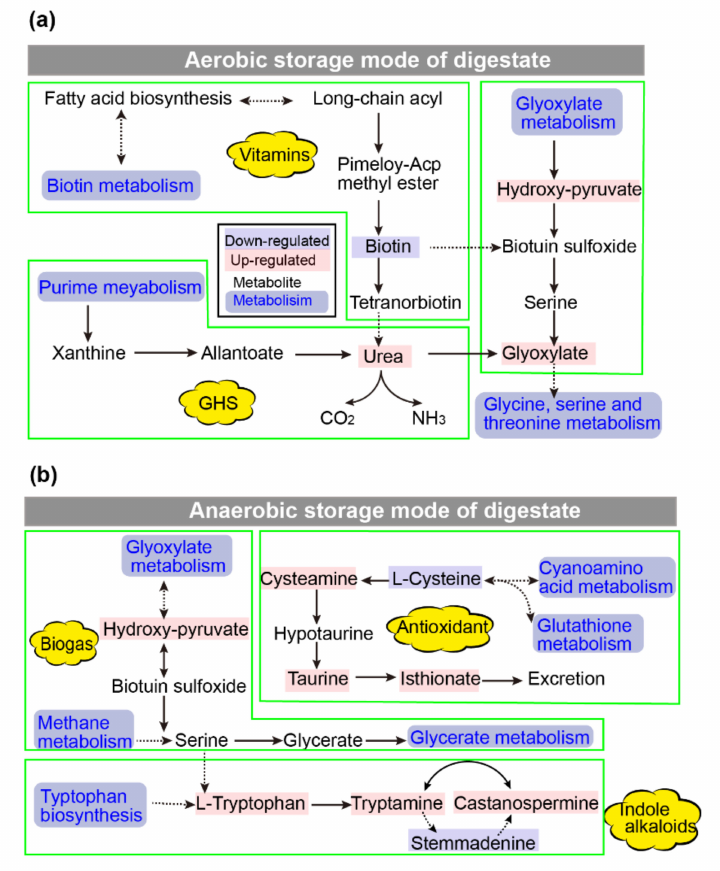
Figure 5. Schematic overview of the metabolic pathways in digestate stored under aerobic and anaerobic mode. ( a ) The main metabolic pathways of digestate in aerobic storage mode. ( b ) The main metabolic pathways of digestate in anaerobic storage